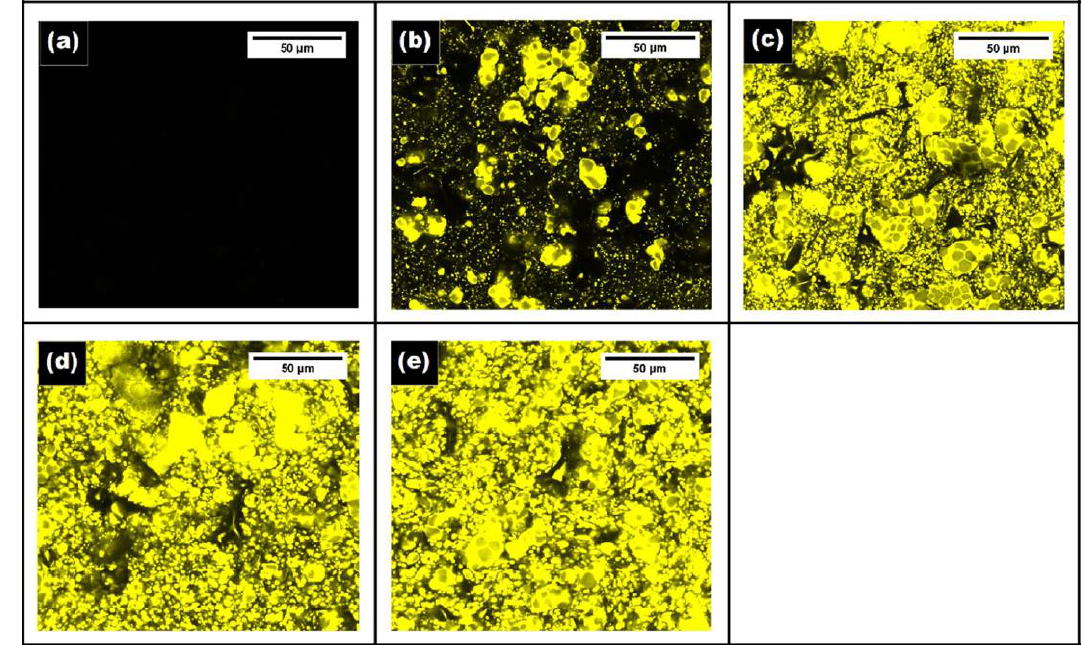
Figure 19. Confocal laser scanning microscopic images of tamarind gum film and geraniol (GER) containing films. Films with different GER content (w/w) ( a ) 0 %, ( b ) 0.5 %, ( c ) 1.0 %, ( d ) 2.0 % and ( e ) 3.0 %. Reproduced with permission from [24]. ( Copyright 2018 Elsevier ). Copyright 2020